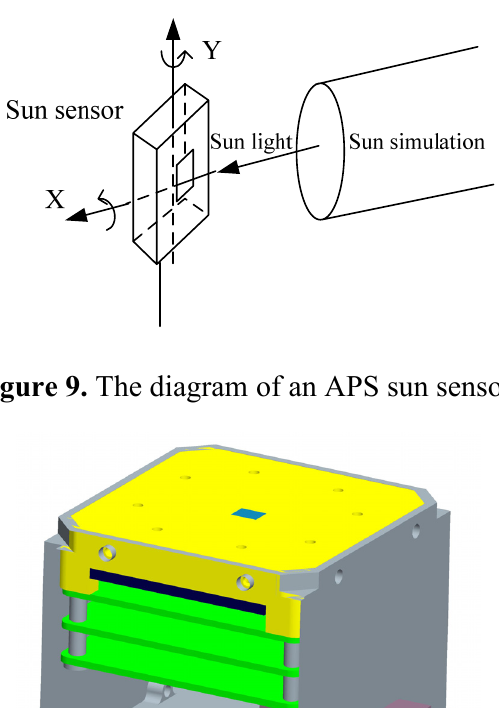
Figure 8. The lab test system for a sun sensor.